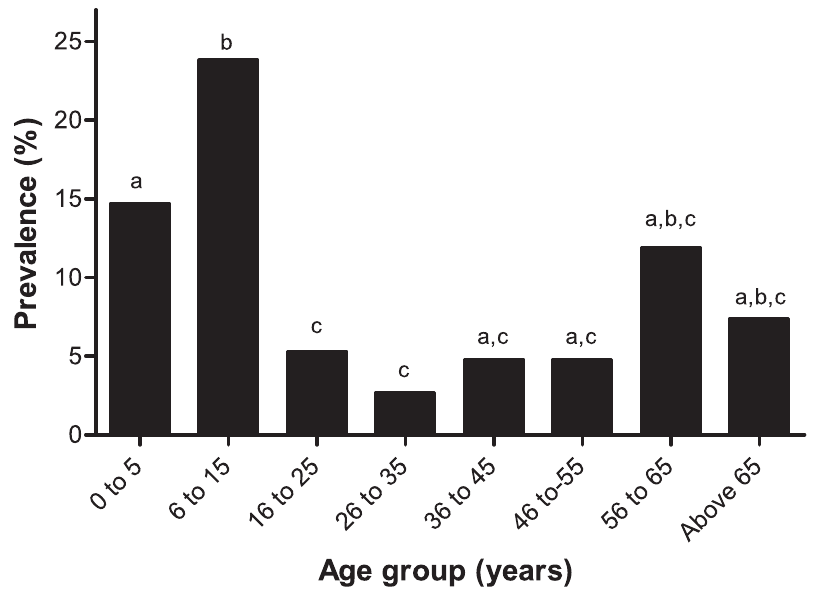
Fig 2. Age-specific prevalence of human tungiasis. Data with the same index letter (a, b, c) are not significantly different from each other in a Chi-square test with p values corrected for multiple testing according to the Bonferroni-Holm